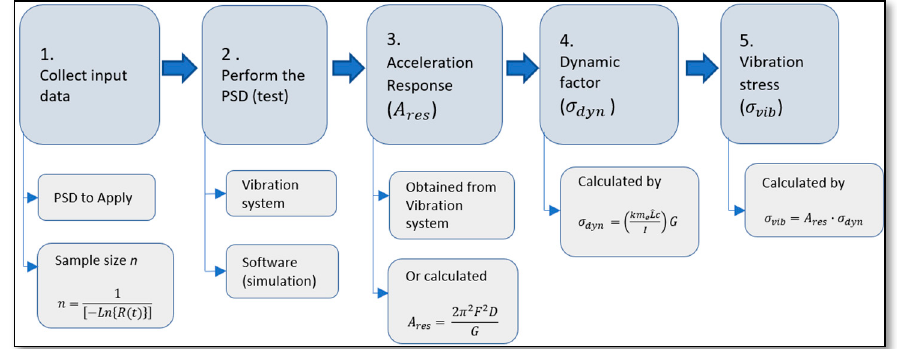
Figure 1. Diagram overview of the vibration stress calculation.